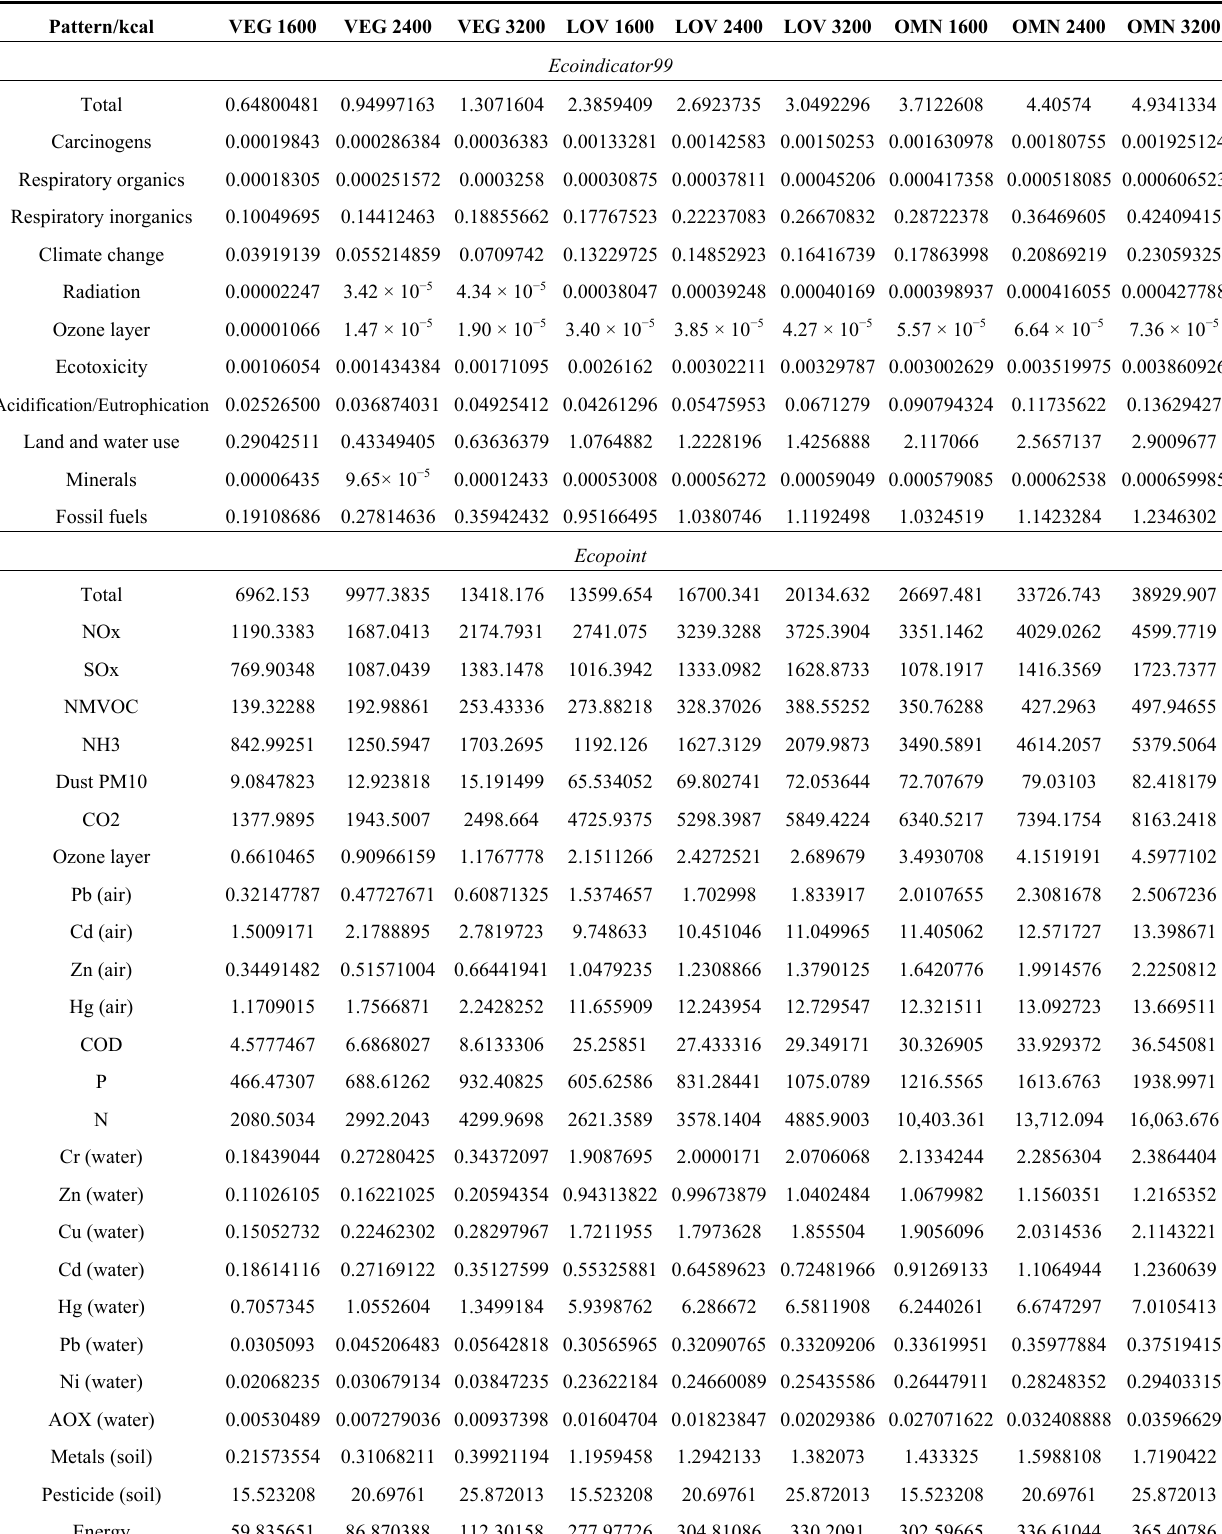
Table 1. Whole diet study: total and partial environmental impacts (indicated as single score, Pt per week) of the three complete food patterns, according to each